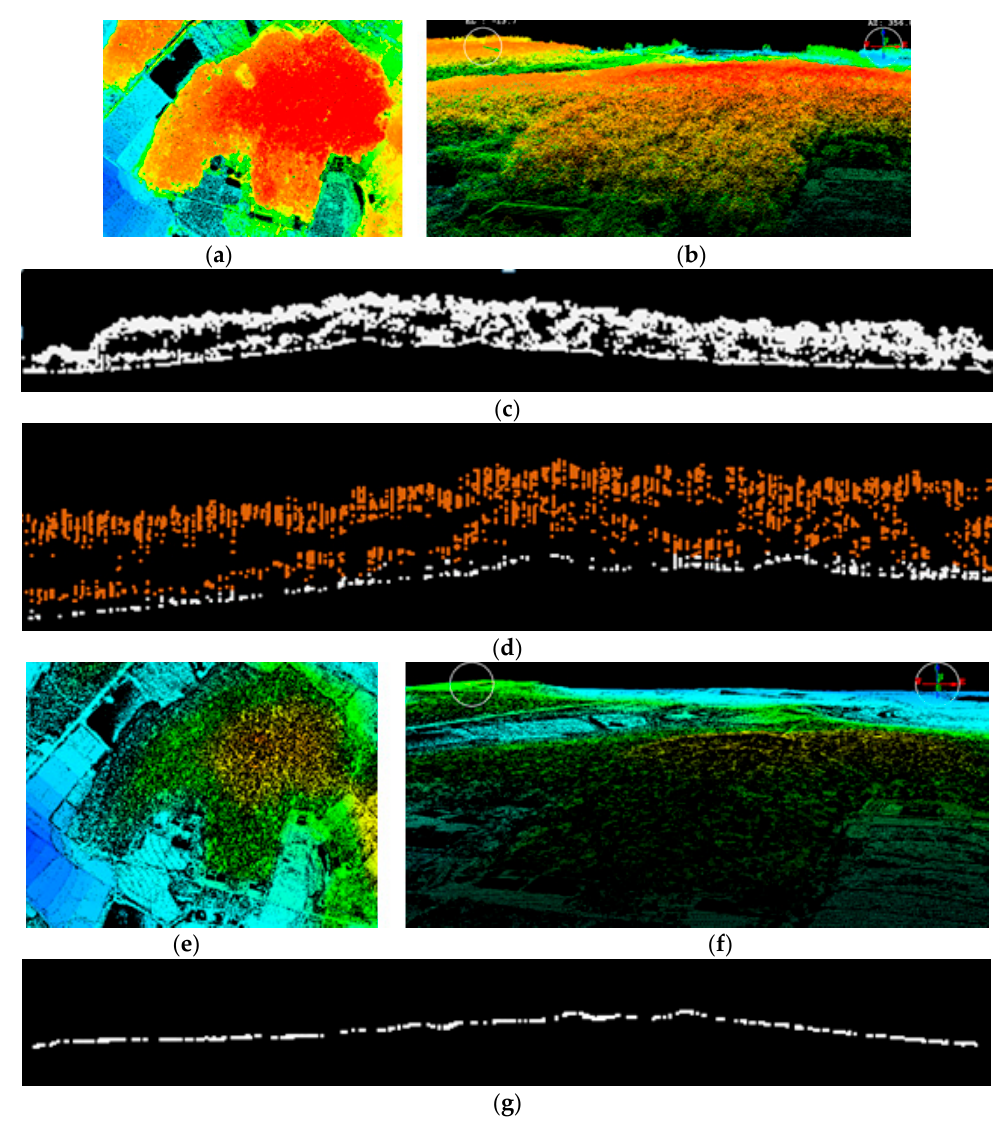
Figure 6. LiDAR point cloud filtering and classification to obtain the ground point cloud. ( a ) Original point cloud; ( b ) 3D view of the original point cloud; ( c ) section of the original point cloud; ( d ) objects in a section of the original point cloud; ( e ) ground point cloud; ( f ) 3D view of the ground point cloud; and ( g ) a section of the ground point cloud.